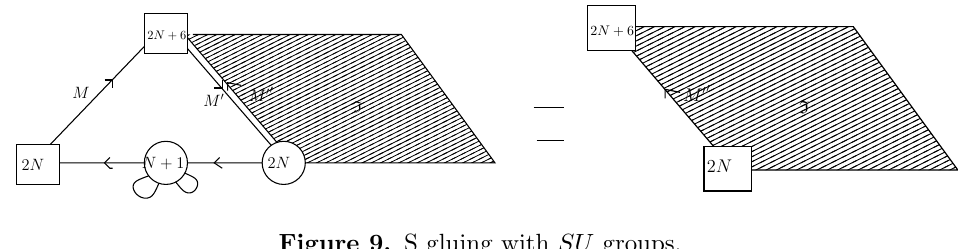
Figure 9. S gluing with SU groups.